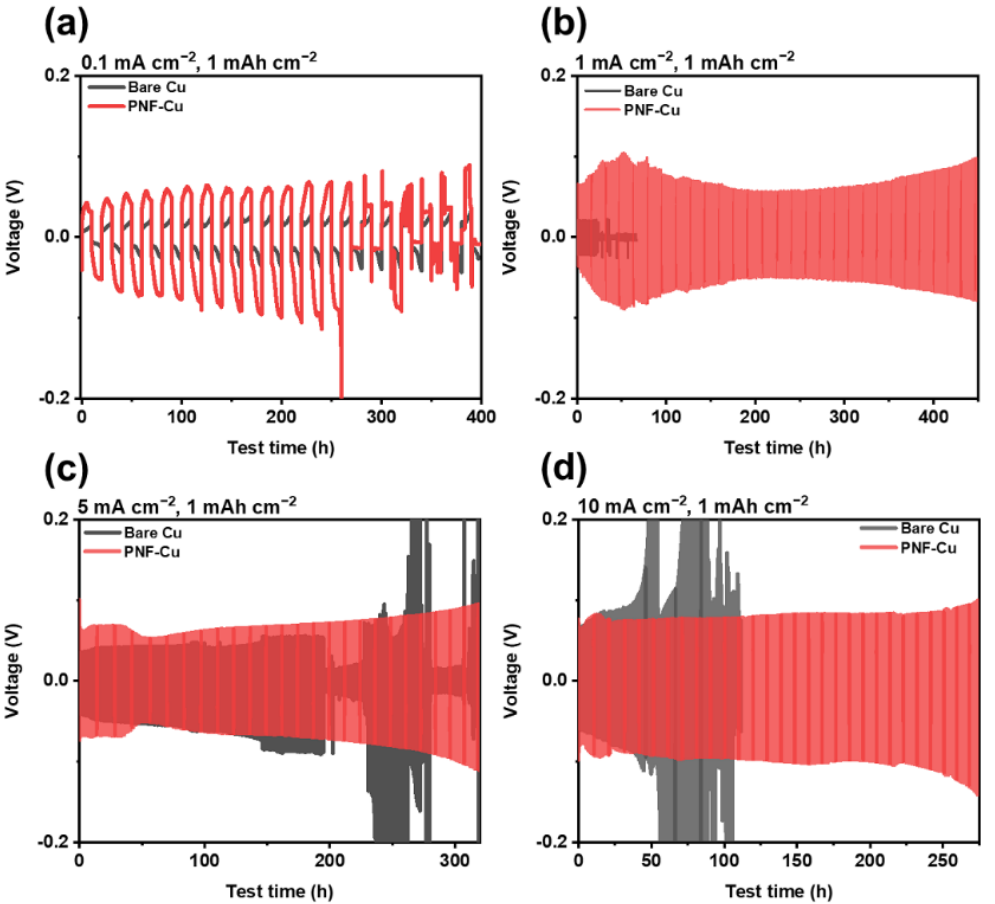
Figure 5. ( a ) Voltage – time curves of symmetric cells of zinc-deposited bare copper and P(VDF-TrFE) electrospun Cu at ( a ) 0.1, ( b ) 1, ( c ) 5, and ( d ) 10 mA cm −2 .